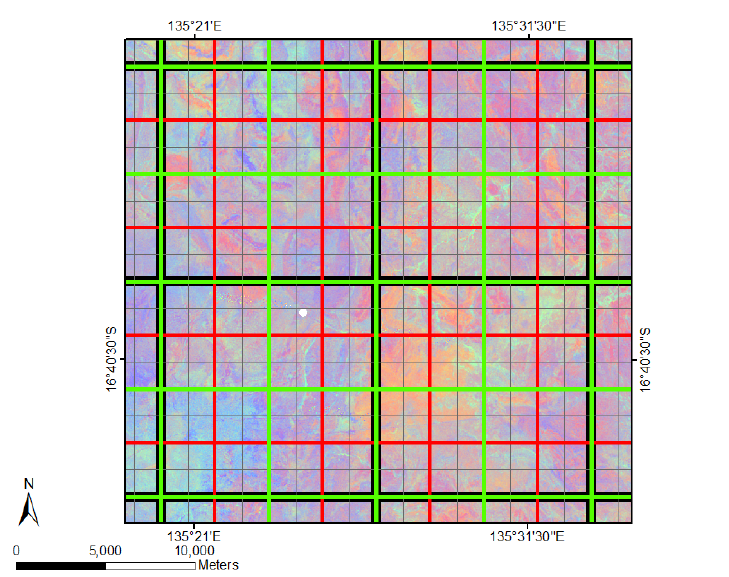
Figure 7. Combination of all four spatial grids used as an overlay for the data delineation of green vegetation fractions out of FCover scenes. The thick black outline shows the resolution in 12,000 m, green in 6000 m, red in 3000 m and thin grey in 1500